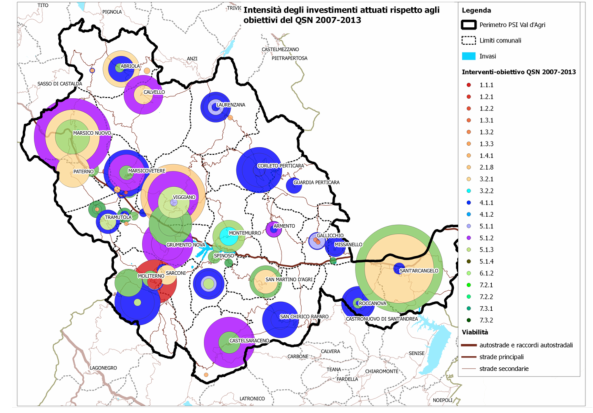
Figure 5. Classification of interventions.